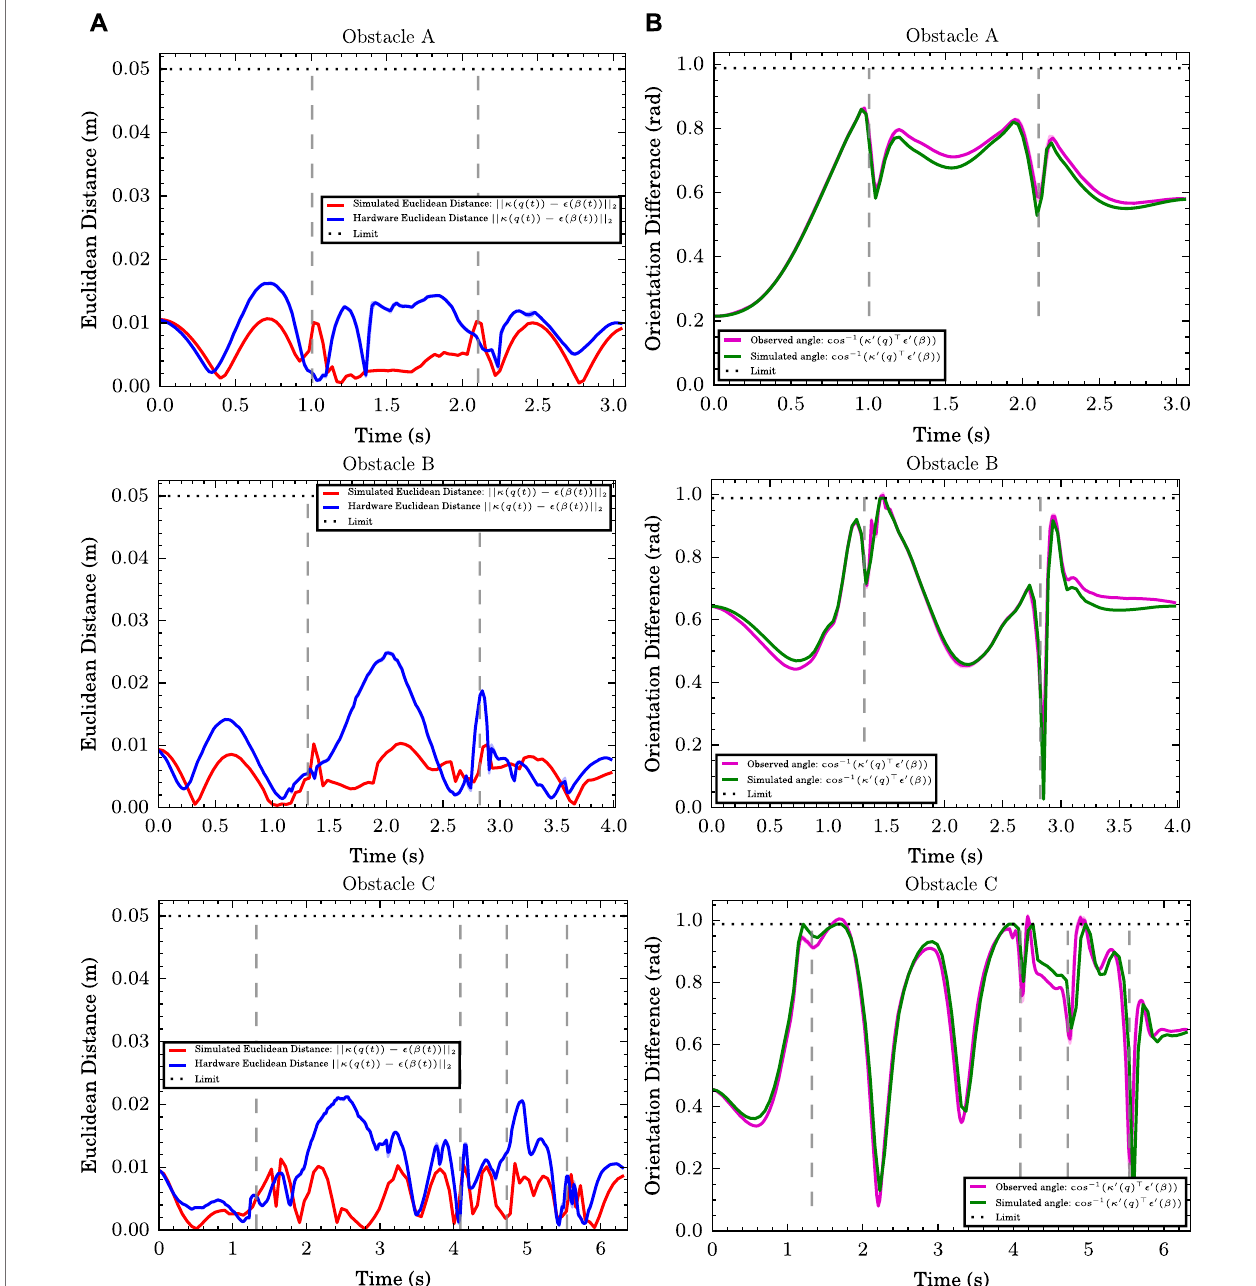
FIGURE 3 | (A) Euclidean distance between the end-effector centre and the target obstacle position throughout the simulated (red) and hardware trials (blue) for obstacles A, B and C. (B) Difference in orientation between the obstacle tangent and the end-effector normal for obstacles A, B and C (simulations in green and experiments in magenta). The dashed grey lines indicate the time when the end-effector is at the sharp bend of the obstacle.